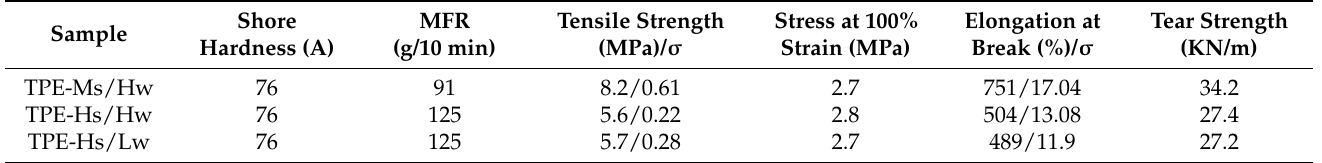
Table 5. Mechanical properties of TPE prepared by SEBS with various styrene content.